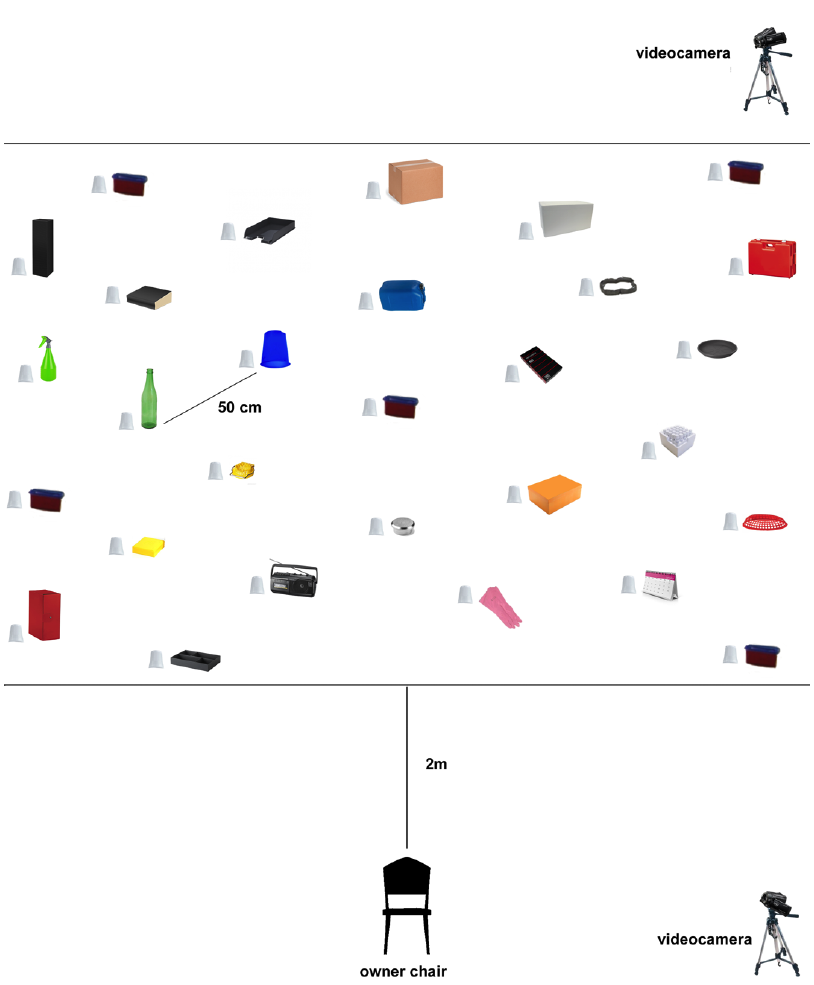
Figure 1. Testing setup.